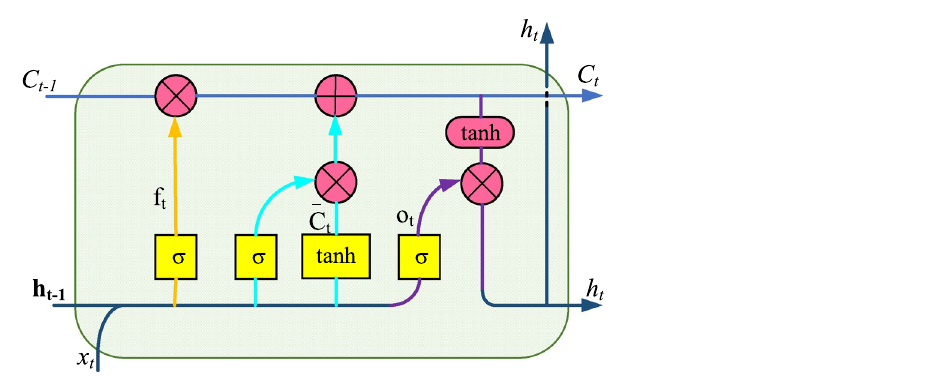
Figure 4. The workflow of multi-step ahead thermal warning network.